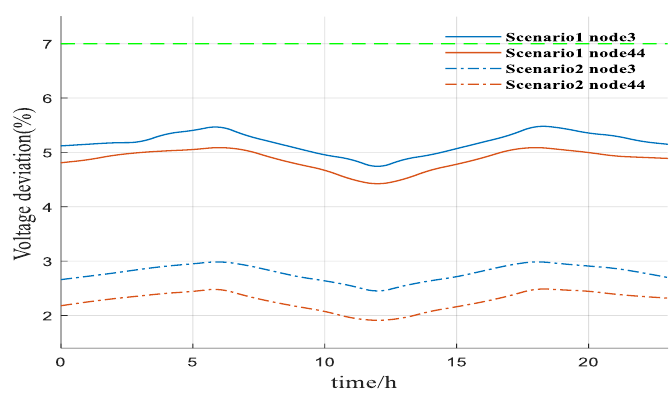
Figure 11. Voltage deviation curve.